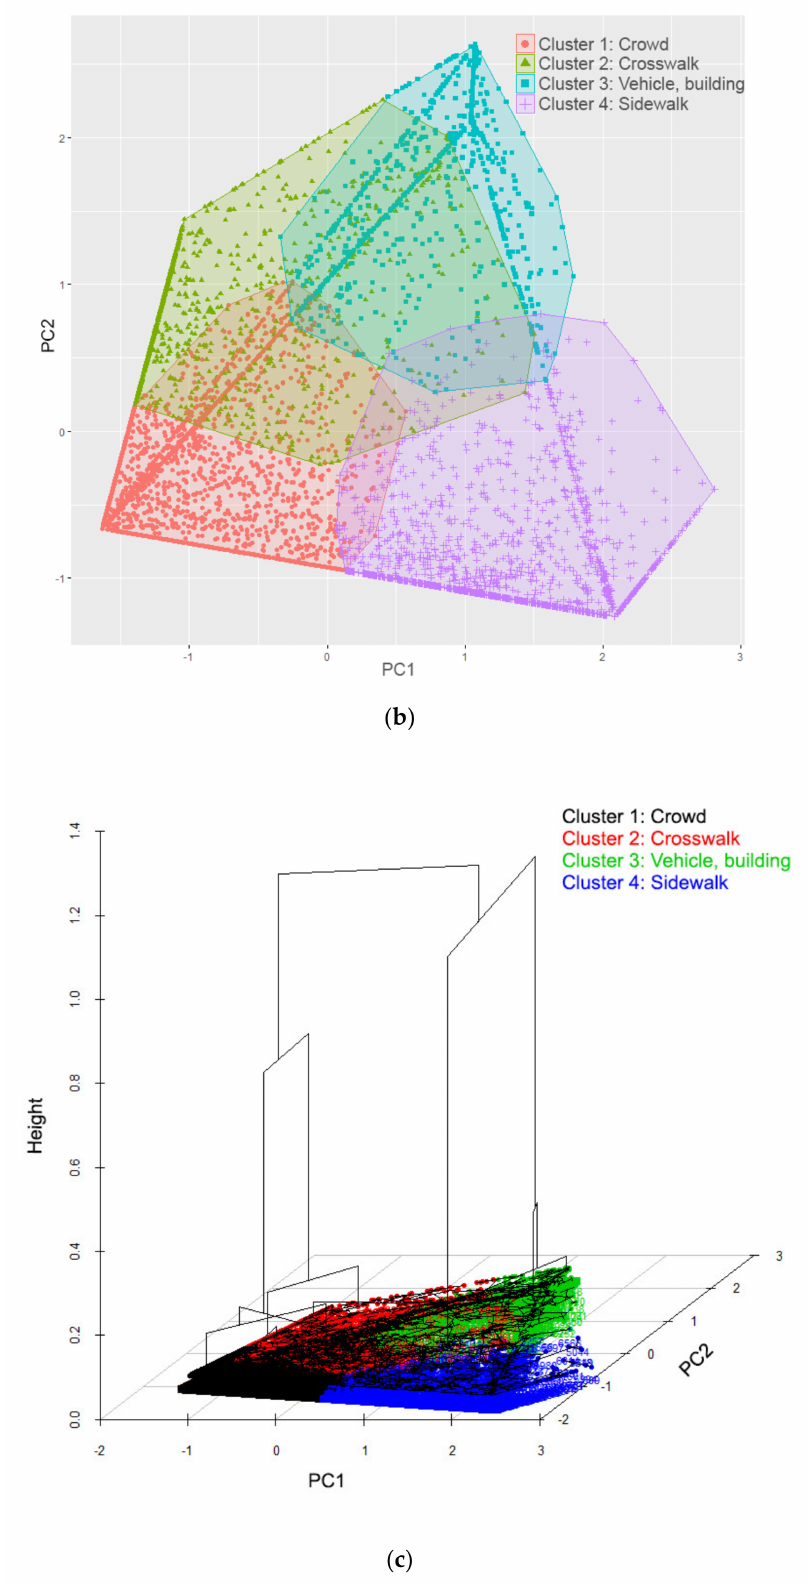
Figure 10. Results of k -means clustering of the pedestrians by the ground features. ( a ) Iterative tests of k -means clusters, where the elbow point was found at k = 4; ( b ) four clusters detected and associated with meanings; ( c ) the hierarchical closeness between the